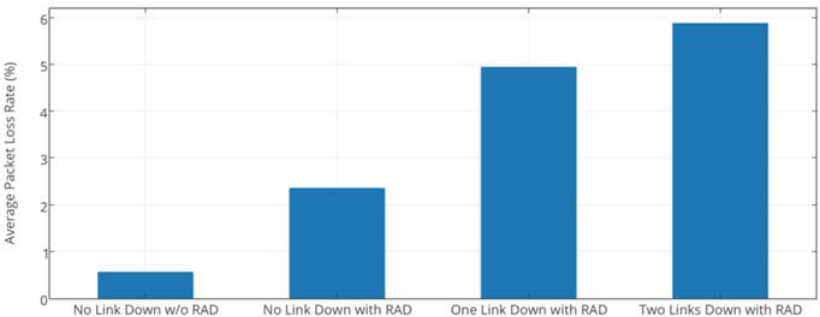
Figure 4. Average packet loss rate (%) vs. the number of links down.